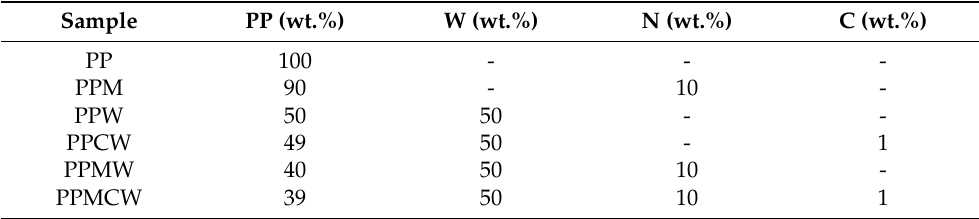
Table 1. Samples composition. PP: polypropylene; W: industrial waste; M: masterbatch; N: nano- calcium carbonate; C: